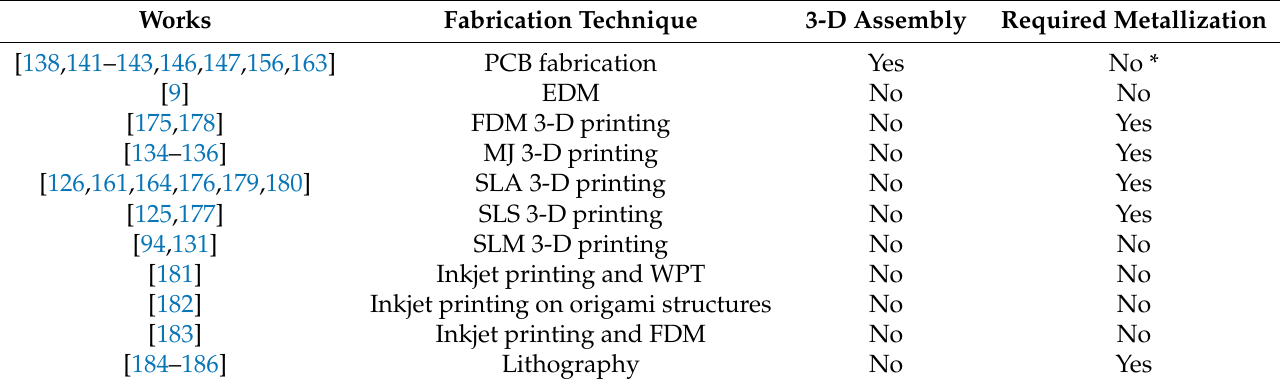
Table 2. Summary of the fabrication characteristics of the studies mentioned in Section